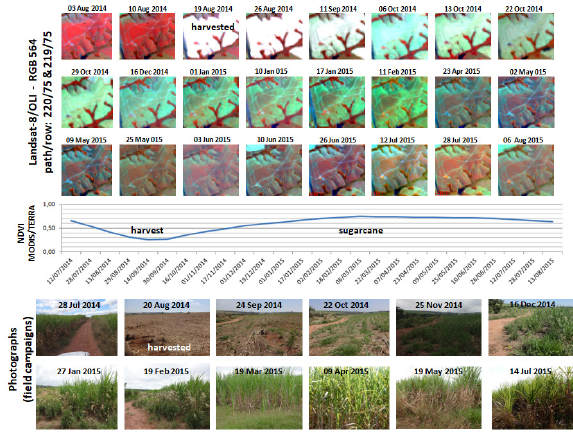
Figure 3. Field and satellite data of an area cultivated with sugarcane. Source: Parts of the figure was adapted from Formaggio and Sanches